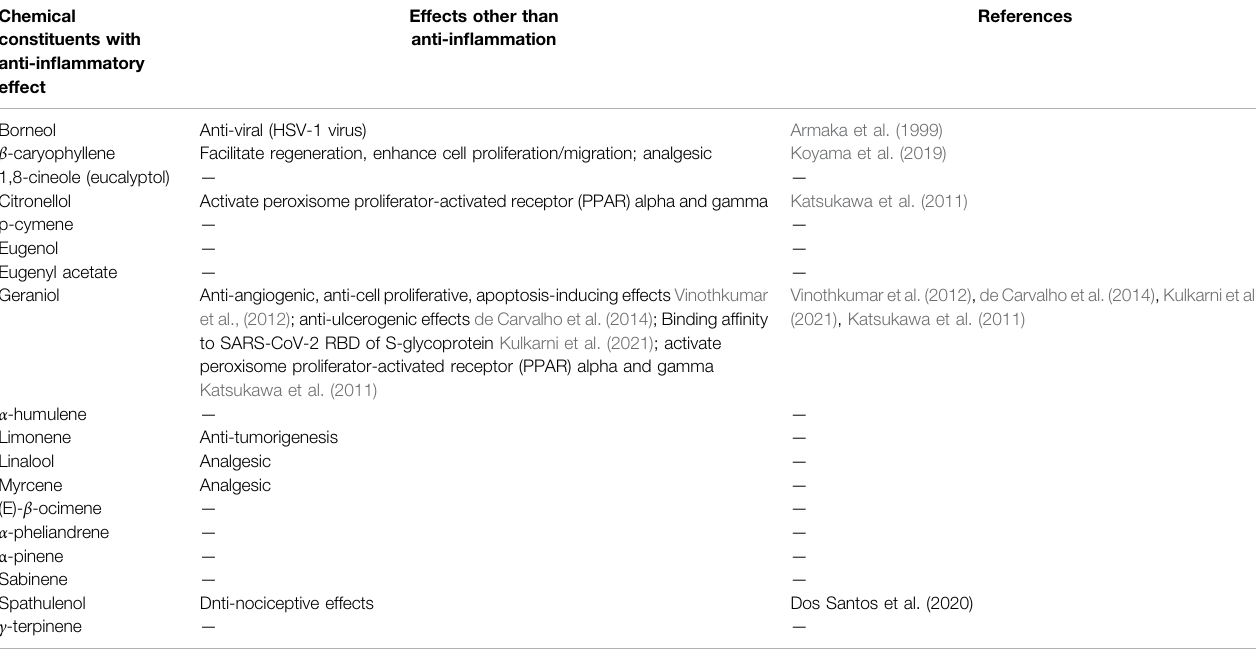
TABLE 5 | Chemicals compounds in the four essential oils with anti-in fl ammatory effects and binding af fi nity with SARS-CoV-2. Chemical constituents